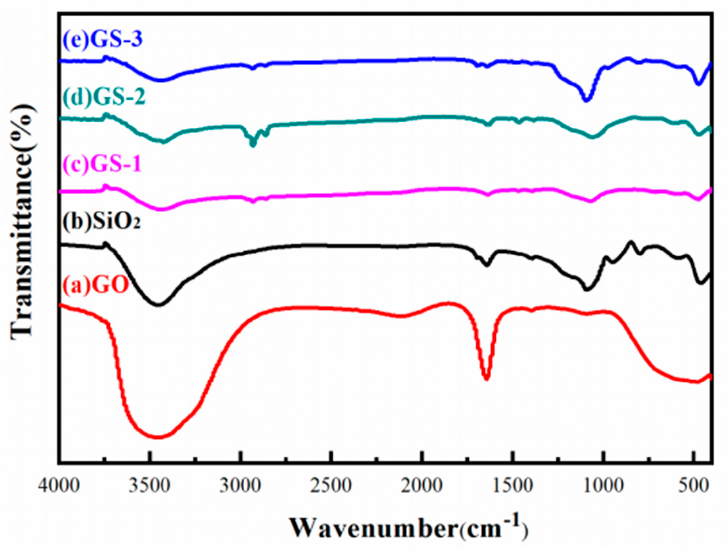
Figure 1. Fourier-transform infrared (FTIR) spectra of GO, SiO 2, GS-1, GS-2 and GS-3.